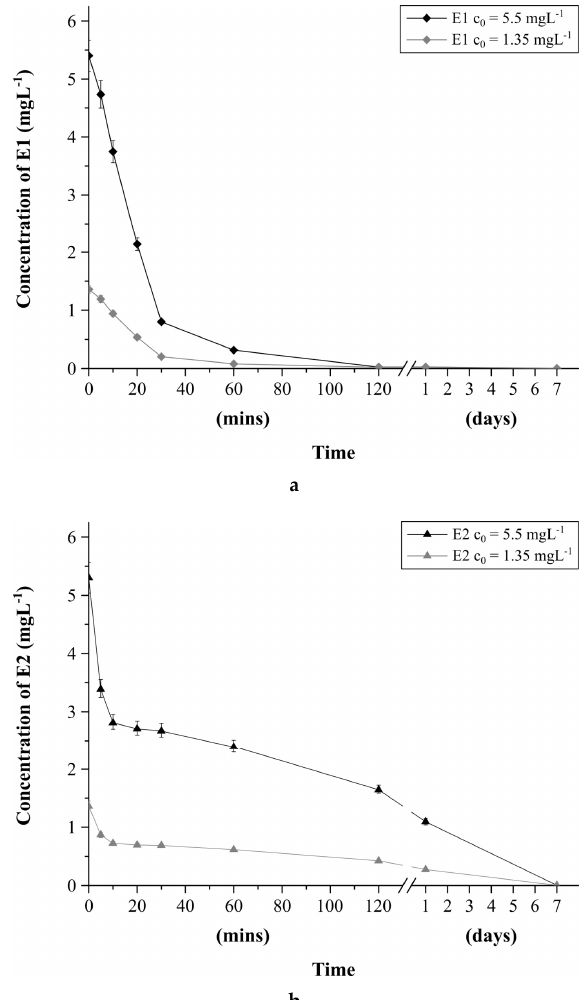
Figure 5. ( a ) Concentration of E1 in aqueous solution as a function of time. ( b ) Concentration of E2 in aqueous solution as a function of time.